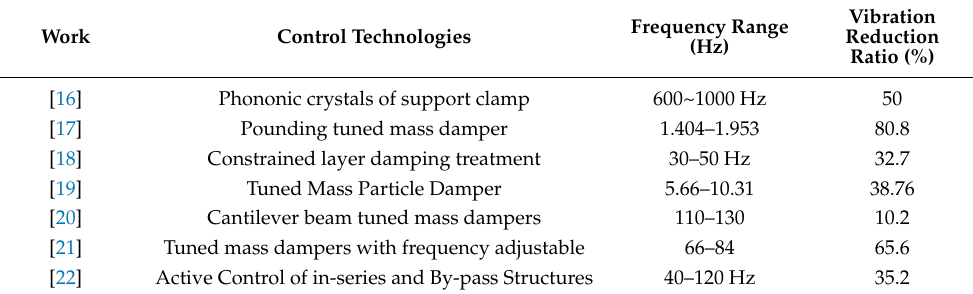
Table 6. Background of vibration control technologies of hydraulic